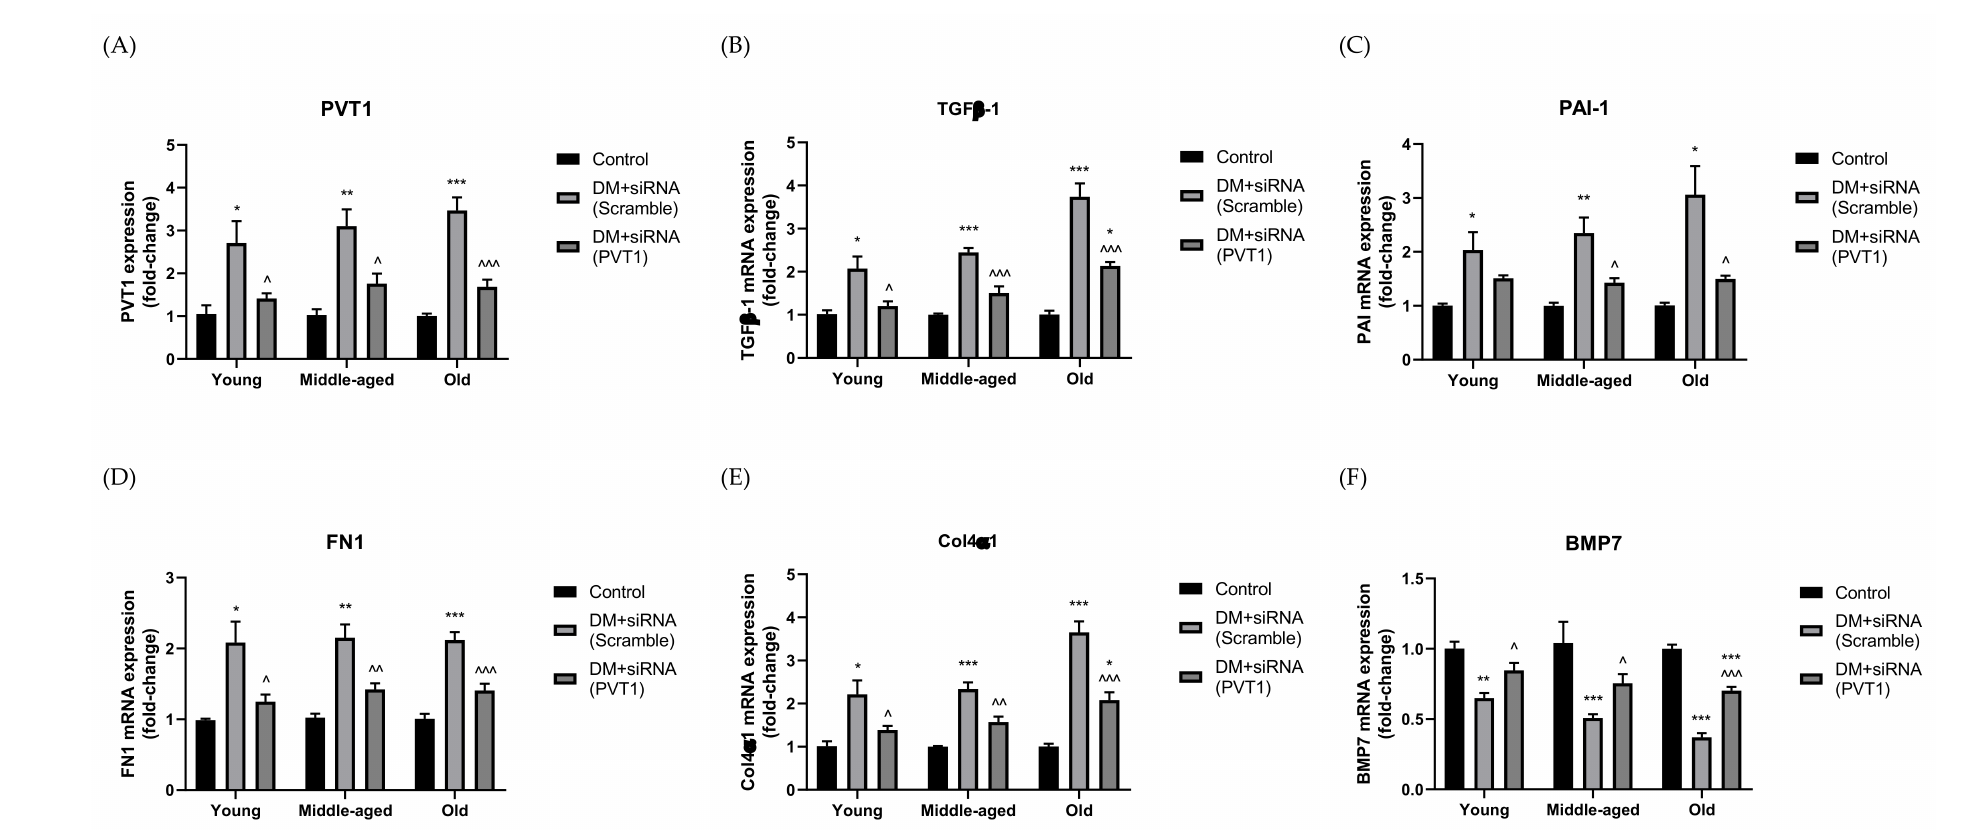
Figure 3. Gene expressions of ( A ) PVT1, ( B ) TGF- β 1, ( C ) PAI-1, ( D ) FN1, ( E ) COL4A1, and ( F ) BMP7 of siRNA-treated diabetic and control mice of different age groups. Diabetic mice were treated with either scramble-siRNA (DM + siRNA (scramble)) or PVT1-siRNA (DM + siRNA (PVT1)), whereas control mice were normal mice without siRNA injection (Control). Data were presented as means ± SEM, n = 6. A p -value < 0.05 was considered statistically significant using one-way ANOVA with Tukey post-test (* p < 0.05, ** p < 0.01, *** p < 0.001 vs. age-matched control; ˆ p < 0.05, ˆˆ p < 0.01, ˆˆˆ p < 0.001 vs. age-matched DM + siRNA (scramble). PVT1 (Plasmacytoma variant translocation 1); TGF- β 1 (Transforming growth factor beta 1); PAI-1 (Plasminogen activator inhibitor-1); FN1 (Fibronectin 1); COL4A1 (Collagen type IV alpha 1); BMP7 (Bone morphogenetic protein